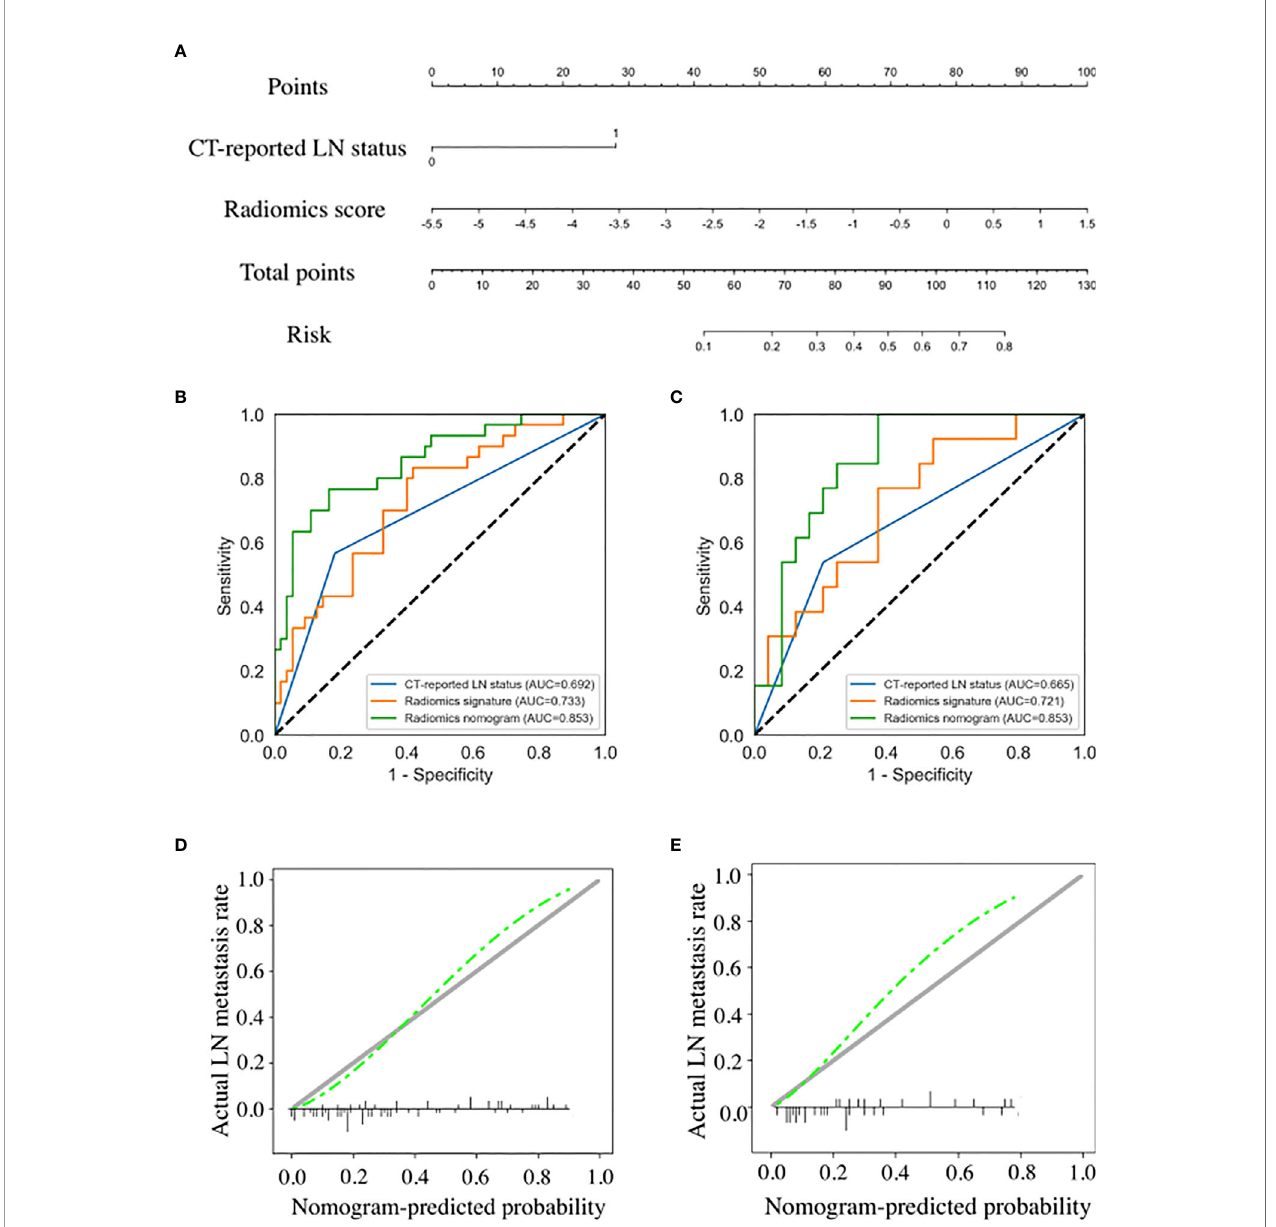
FIGURE 4 | Radiomics nomogram developed with receiver operating characteristic (ROC) curves and calibration curves. (A) A radiomics nomogram incorporating the radiomics signature and CT-reported lymph node (LN) status was developed in the training set. Comparison of ROC curves between the CT-reported LN status, radiomics signature, and radiomics nomogram for the prediction of LN metastasis in the training set (B) and validation set (C) . Calibration curves of the radiomics nomogram in the training set (D) and validation set (E) .